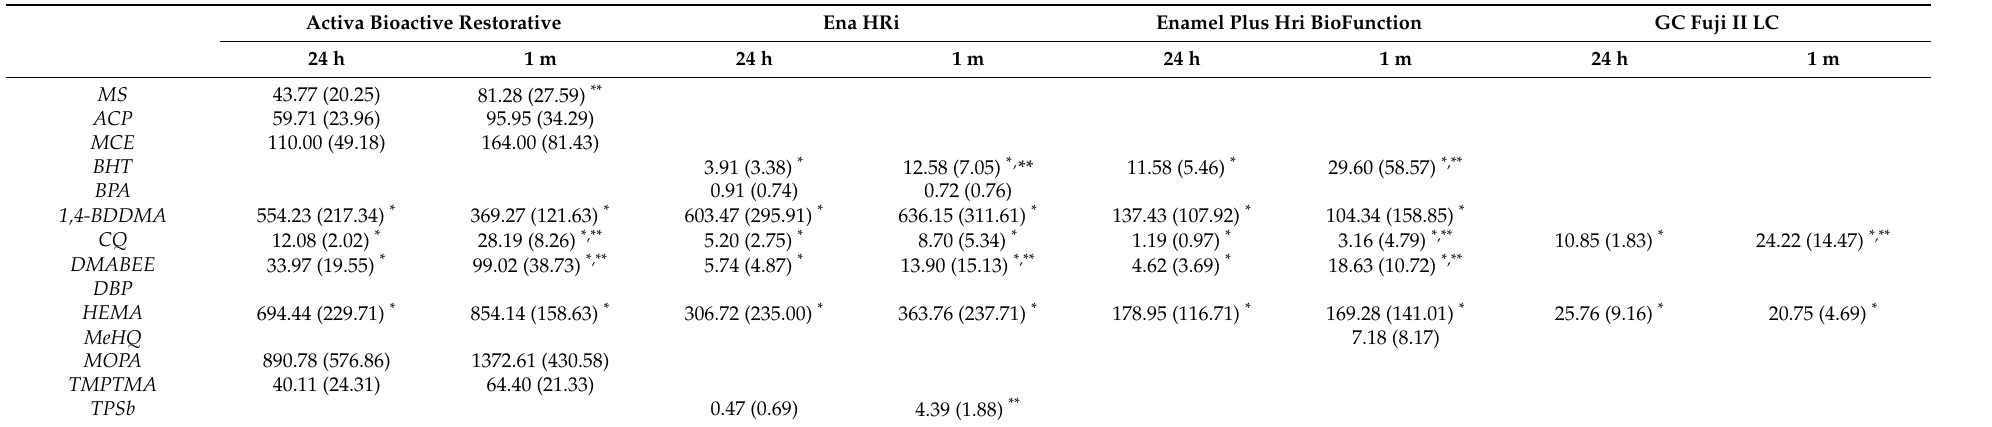
* Indicates significant difference among the materials, ** indicates significant difference according to observation